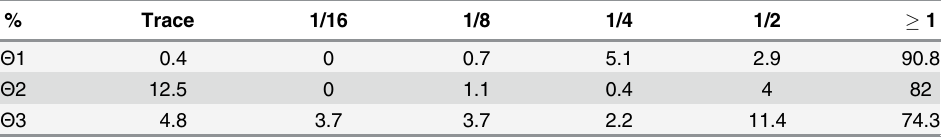
Table 4. Validity of the habitat suitability analysis with respect to the surveillance reports of